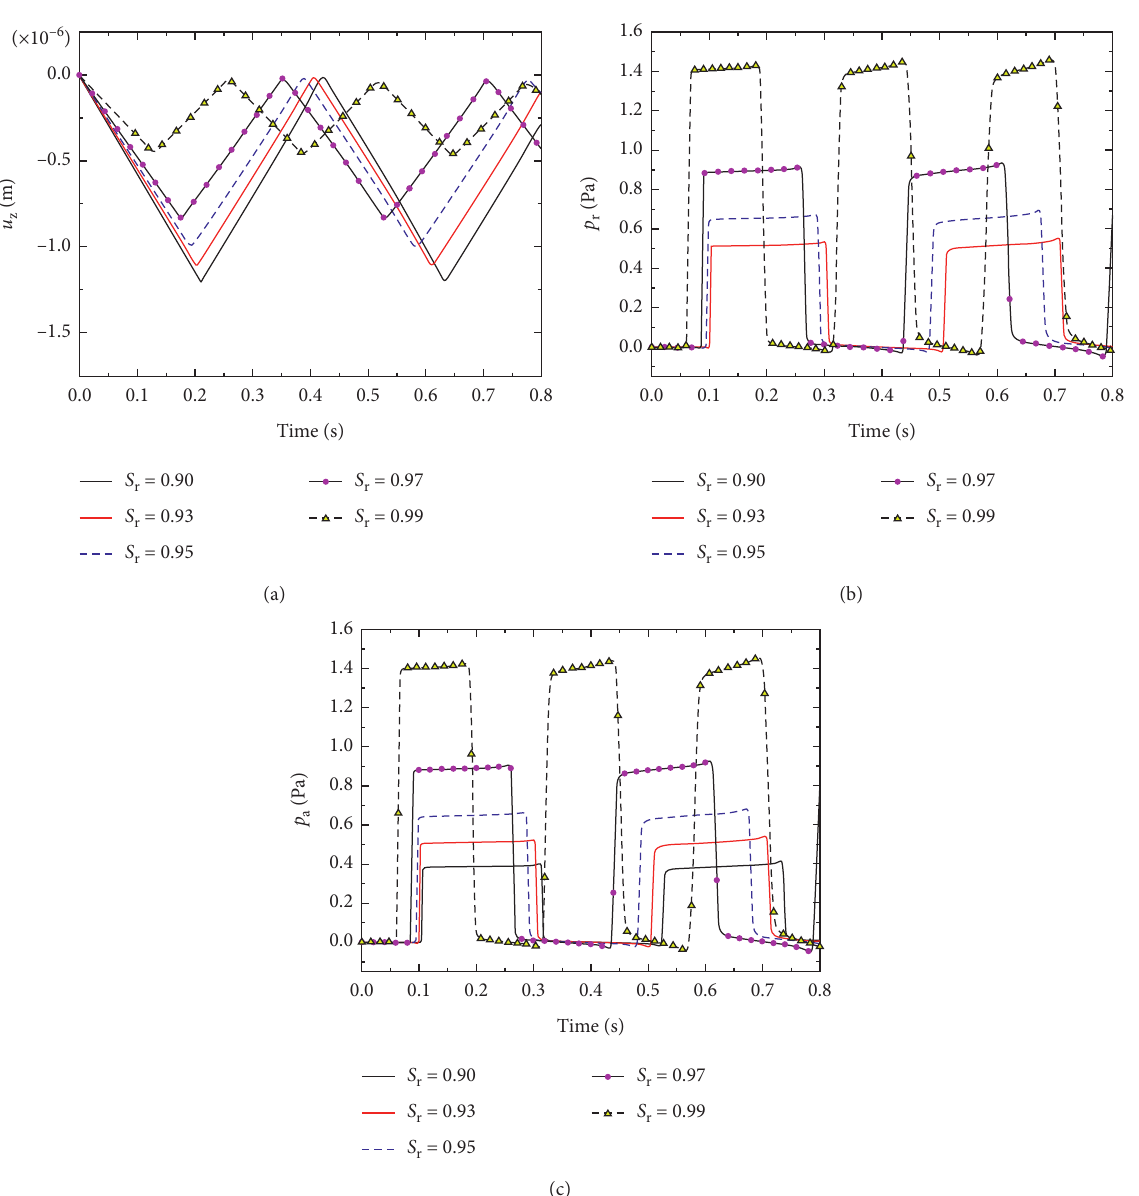
� L ), fluid pressure p � 0), and air pressure p � 0) with z ( t , z f ( t , z a ( t , z